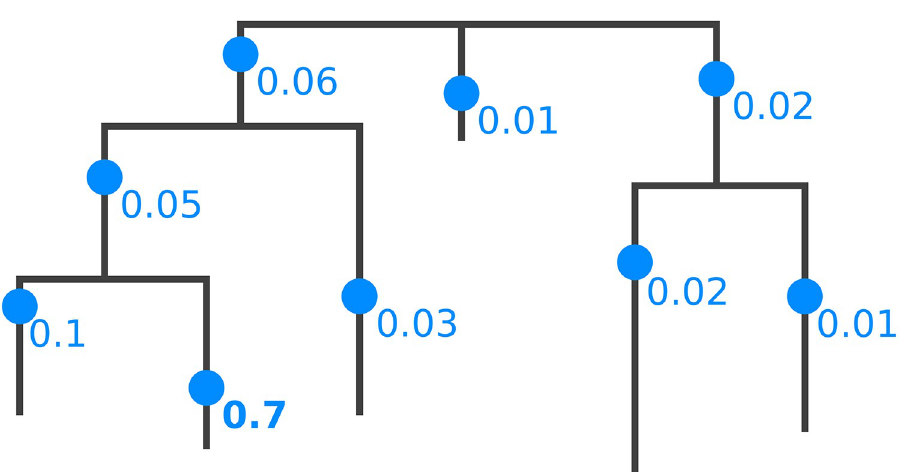
Fig 1. Phylogenetic placement of a single query sequence. Each branch of the reference tree is tested as a potential insertion position, called a “placement” (blue dots). Note that placements have a specific position on their branch, due to the branch length optimization process. A probability of how likely it is that the sequence belongs to a specific branch is computed (numbers next to dots), which is called the likelihood weight ratio (LWR). The bold number (0.7) denotes the most probable placement of the